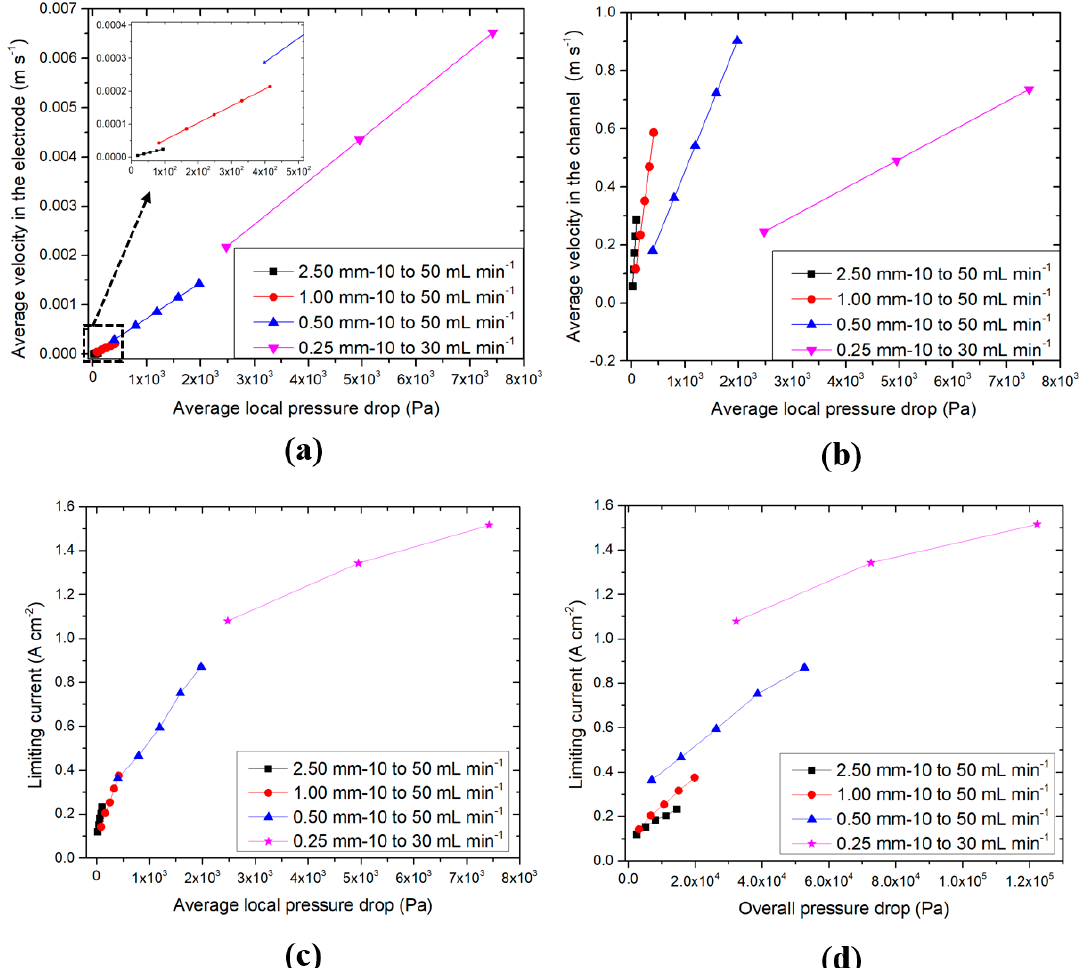
Figure 8. Correlations between ( a ) local pressure drop and average channel velocity, ( b ) local pressure drop and average electrode velocity, ( c ) average local pressure drop and limiting current, and ( d ) overall pressure drop and limiting current.